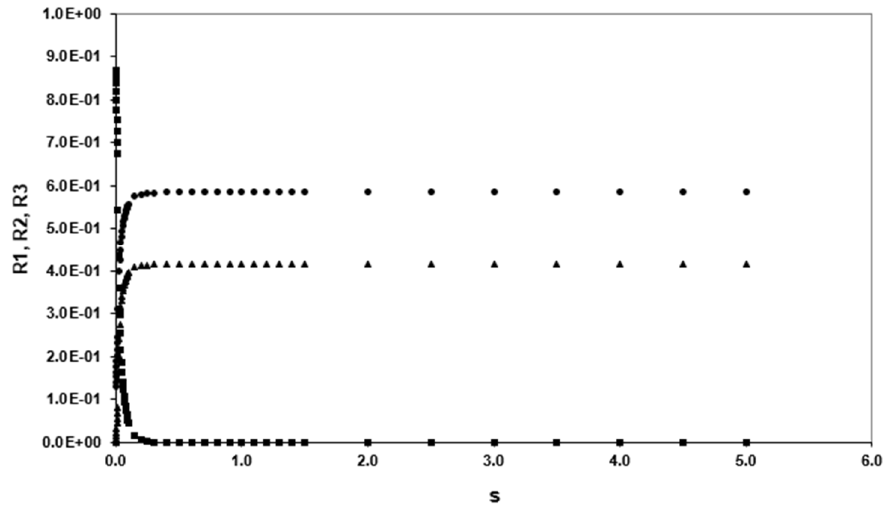
Figure 4. R terms as functions of time. R1 (circles), R2 (squares), R3 (triangles) [H 2 O 2 ] o = 2 mol dm − 3 .